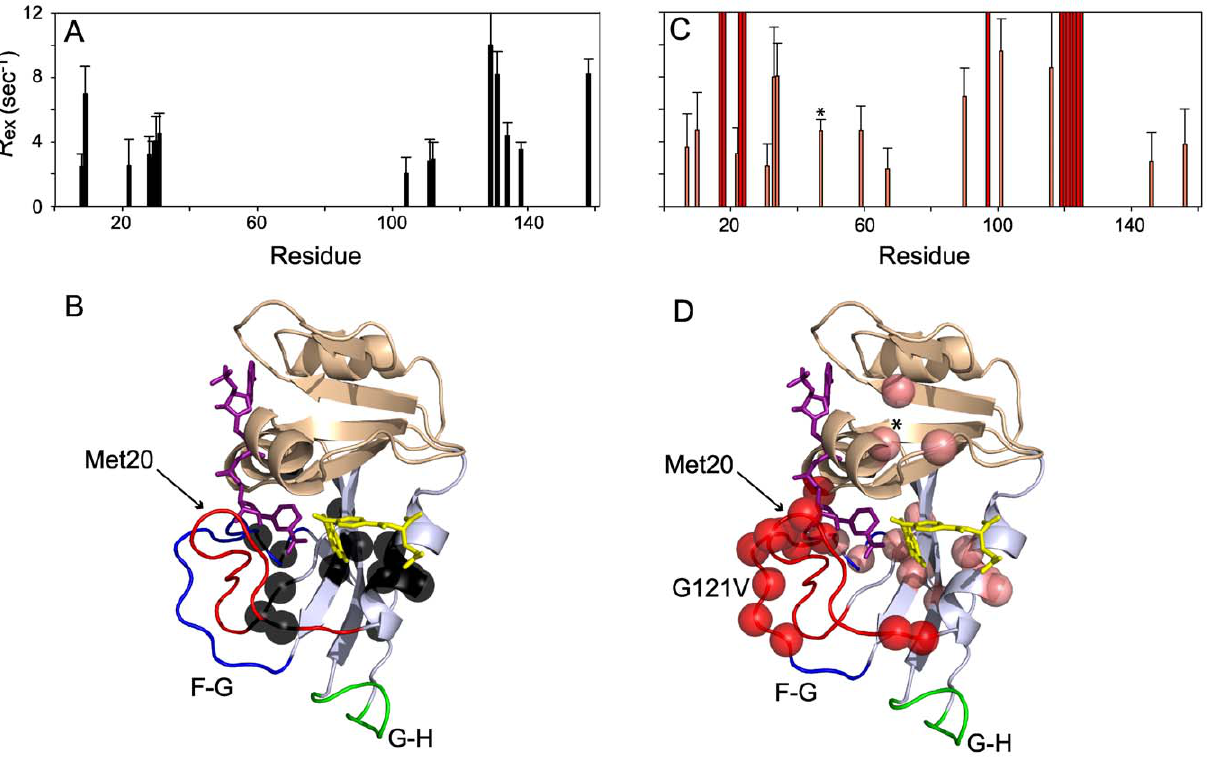
Figure 3. G121V dependent changes in m s-ms motions. Backbone residues with significant ( . 1.5 s ) R ex , as determined by 15 N CPMG relaxation experiments for E:NADPH:MTX (A) and E G121V :NADPH:MTX (C). For E G121V :NADPH:MTX, residues with calculated exchange rates are in pink while residues that could not be assigned because of line broadening are in red. Common residues that could not be assigned in either ternary complex are not included. These residues also mapped onto the structure using black spheres for E:NADPH:MTX (B) and pink or red spheres, denoting CPMG- based R ex or missing respectively, for E G121V :NADPH:MTX (D).